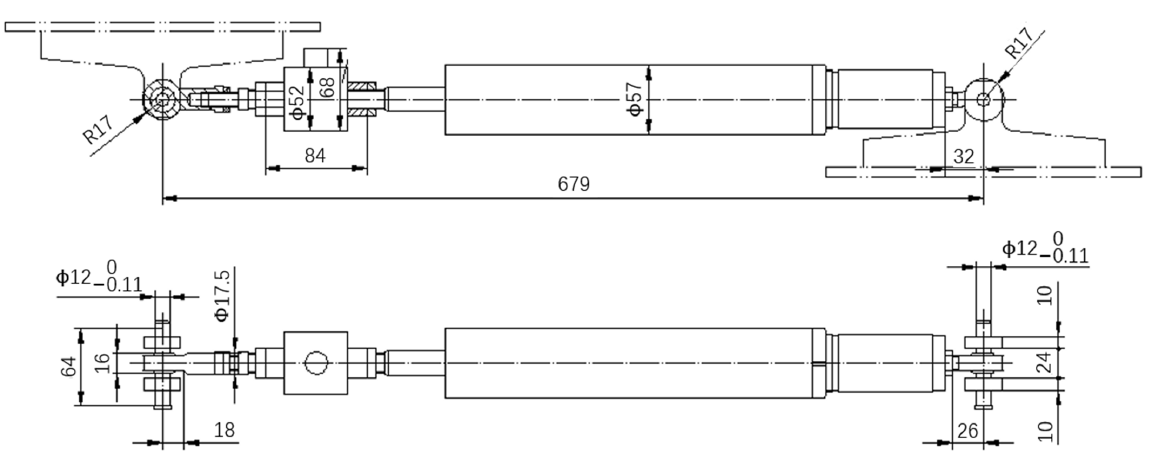
Figure A4. Viscous damper (unit: mm).